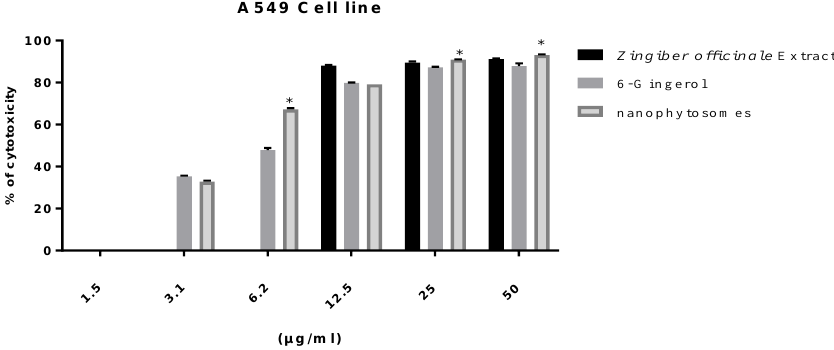
Figure 2. Effect of Zingiber officinale extract, 6-gingerol, and 6-gingerol-loaded PEGylated nanophy- tosomes on cytotoxicity of A549 cells compared with control (6-gingerol). * Statistically different at significance level p < 0.05.